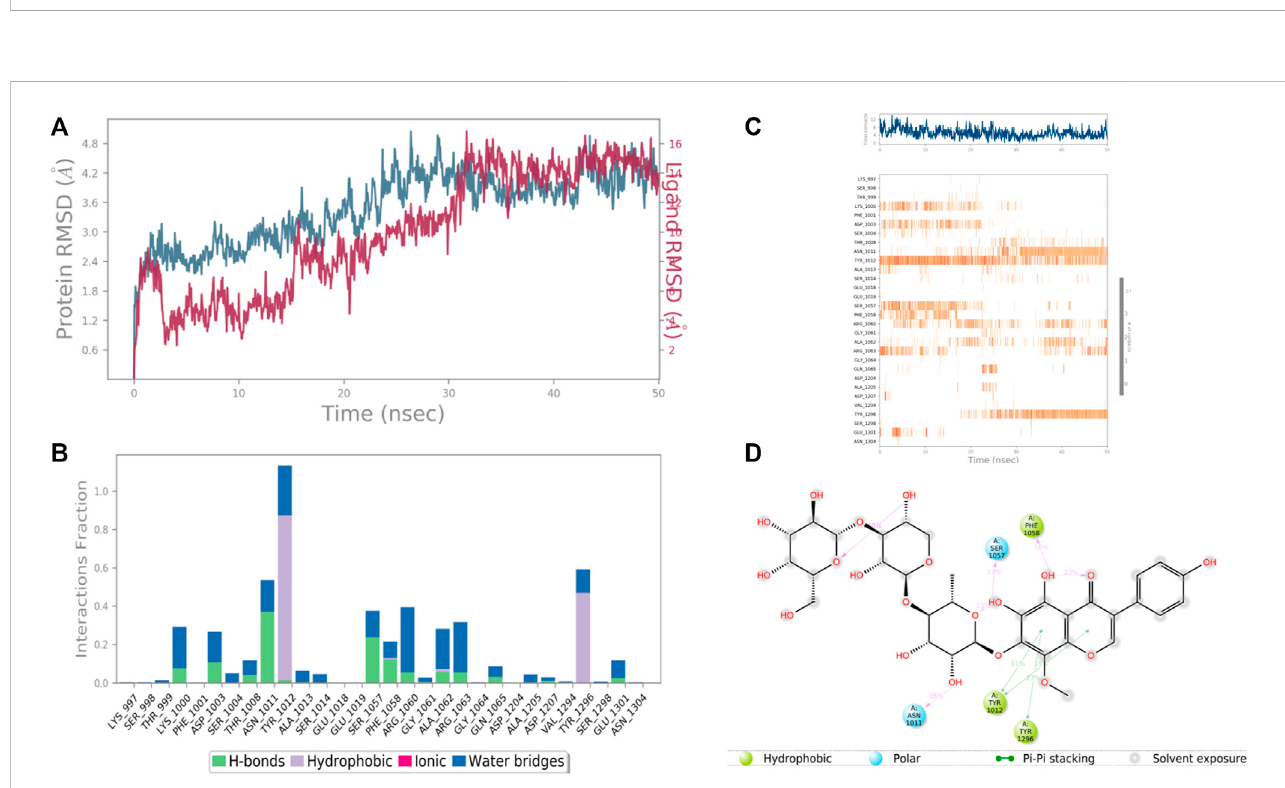
FIGURE 12 RMSD plot of the protein – ligand complex (PDB ID: 3FAY) (A) , Protein-ligand contacts (B) , stacked bar plot of the fraction of time of the interactions (C) and Ligand- Protein contacts (D) of analogue 4 ′ ,5,6,7-Tetrahydroxy-8-methoxyiso fl avone-7-O-beta-D-galactopyranosyl-(1 → 3)-O-beta-D-xylopyranosyl- (1 → 4)- O-alpha-L-rhamnopyranoside for 50 ns of simulation